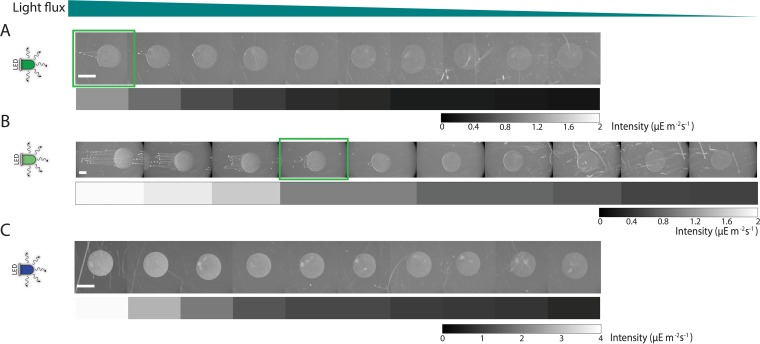
Green light promotes intensity-dependent phototaxis, while blue light stimulates Synechocystis growth but does not induce phototaxis. (A) Under illumination from a low-intensity green LED, communities experienced intensities ranging from 0.35 to 1.38 µE m−2 s−1 (measured at 535 nm). Communities were imaged after 48 h. Community movement toward the LED increased with increasing light intensity. The brightness of the communities indicated that there was also more cellular proliferation at higher intensities. (B) Under illumination from a high-intensity green LED, communities experienced intensities ranging from 0.51 to 1.97 µE m−2 s−1 (measured at 535 nm). Communities were imaged after 48 h. Movement toward the LED increased with increasing intensity, as shown in panel A, with the boxes highlighted in green experiencing similar incident intensities and exhibiting similar phototaxis. (C) Under blue light illumination, communities experienced intensities ranging from 0.65 to 3.91 µE m−2 s−1 (measured at 435 nm). Communities were imaged after 48 h. There was no net movement toward the LED. Cellular proliferation increased with increasing incident intensity. Bar, 2 mm (all panels). Similar behavior was observed in 7 experiments.